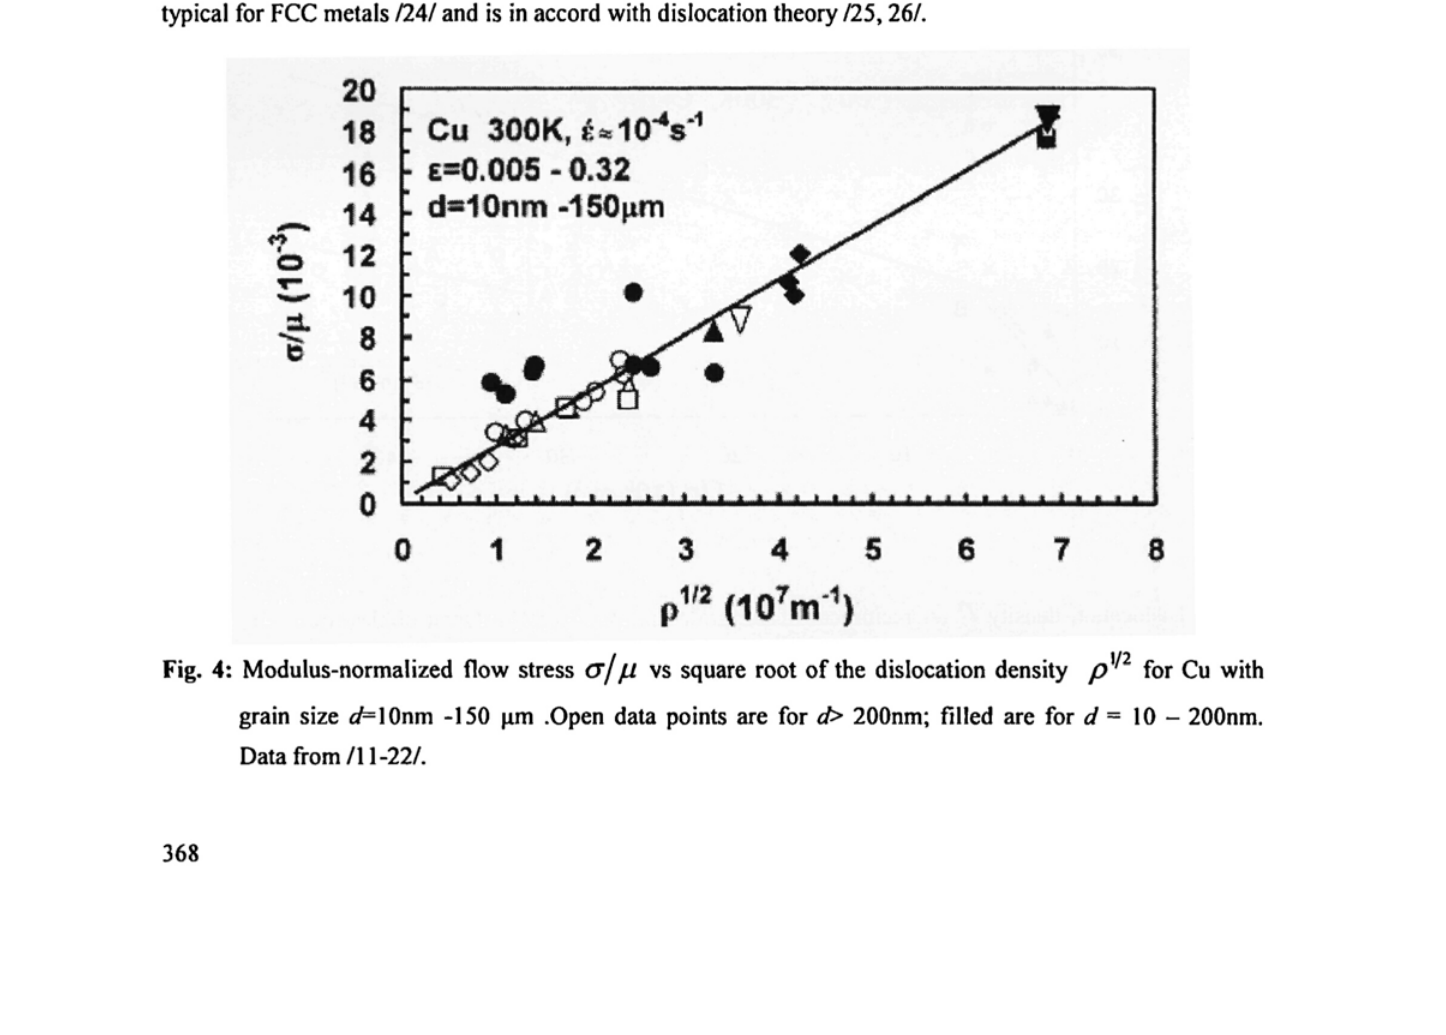
Fig. 4: Modulus-normalized flow stress σ/ μ vs square root of the dislocation density ρ for Cu with grain size d=\0nm -150 μιτι .Open data points are for d> 200nm; filled are for d = 10 - 200nm. Data from